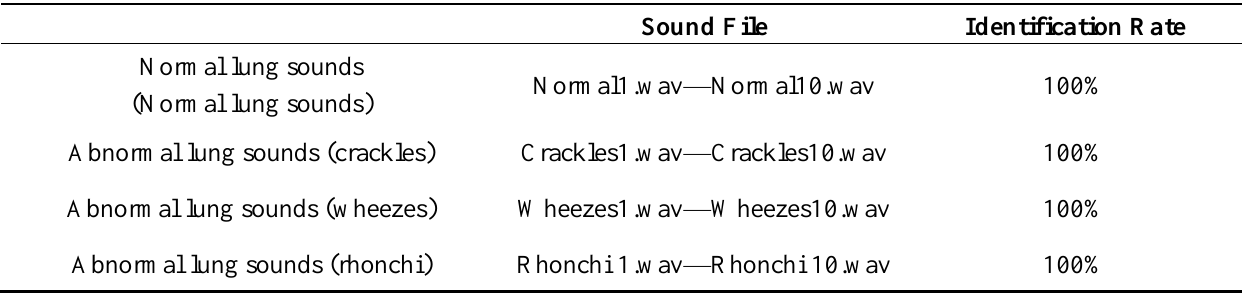
Table 5. Identification results of normal and abnormal lung.